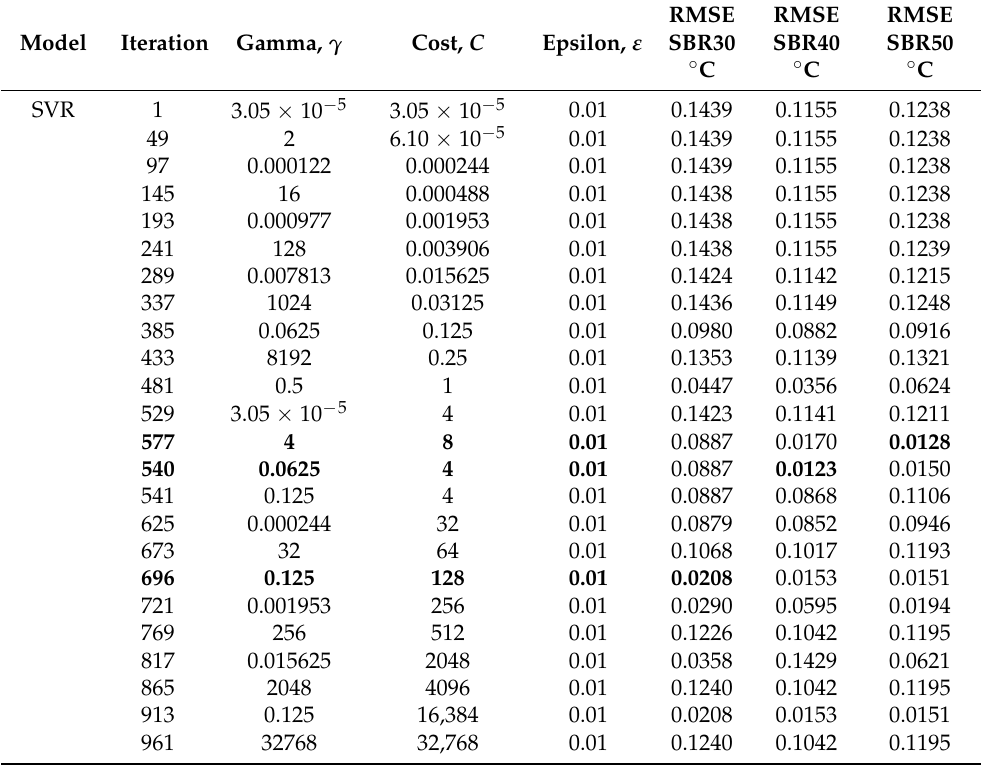
Table 2. Performance of training SVR models with hyperparameters selection for SBR30 ◦ C, SBR40 ◦ C, and SBR50 ◦ C (the best models are in bold).